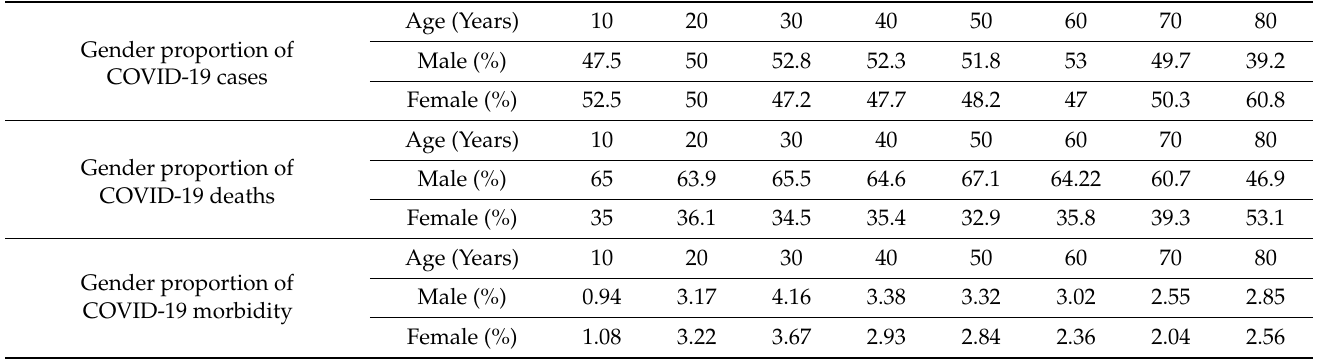
Table 1. Ratio of COVID-19 (cid:48) s cases, deaths, and morbidity according to different age groups.